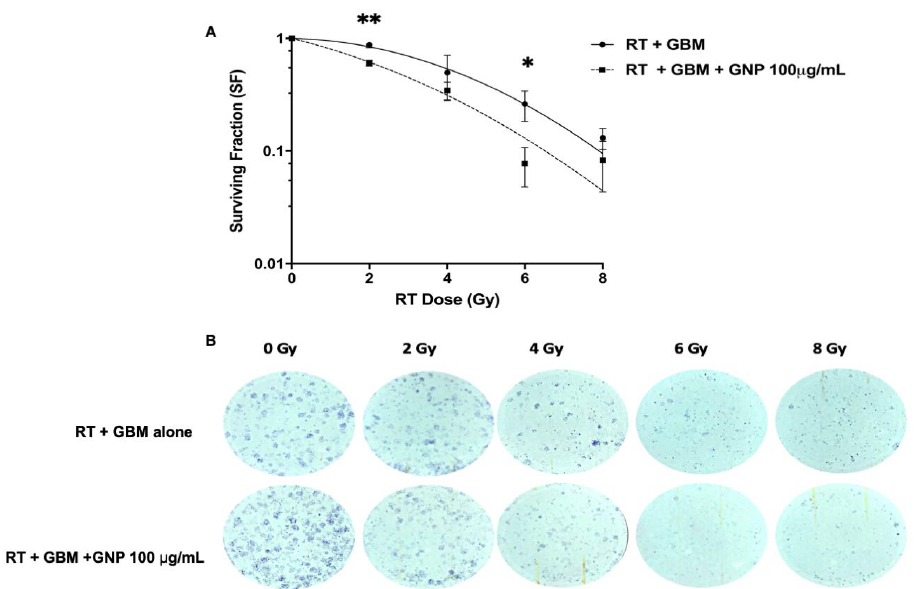
Figure 3. Radiosensitization of U87 GBM by gold nanoparticles. Figure 3 A represents the survival curves for U87 GBM cells irradiated with 6 MV X-rays. Data were fitted based on a linear quadratic model comparing the non-GNP treated group and the GNP (100 µ g / mL) treated group. Post irradiation, 2000 cells were counted and plated. Error bars represent the standard deviation of mean for three independent experiments. Significance tested by multiple t -test, * = p < 0.05 and ** = p < 0.01. Figure 3 B shows representative images of the colonies for the GBM alone and GBM + GNP 100 µ g / mL groups at radiation dose 2, 4, 6, and 8 Gy. In the GBM alone group, the number of colonies formed at day 10 were 74, 66, 54, 19, and 10 at 0, 2, 4, 6, and 8 Gy, respectively. In GBM + GNP 100 µ g / mL wells, the number of colonies formed were 92, 62, 42, 8, and 8 at the respective radiation dose points.